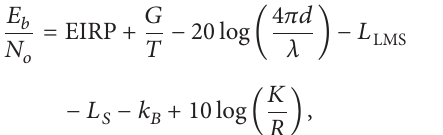
assumed based on the measurements discussed in Section